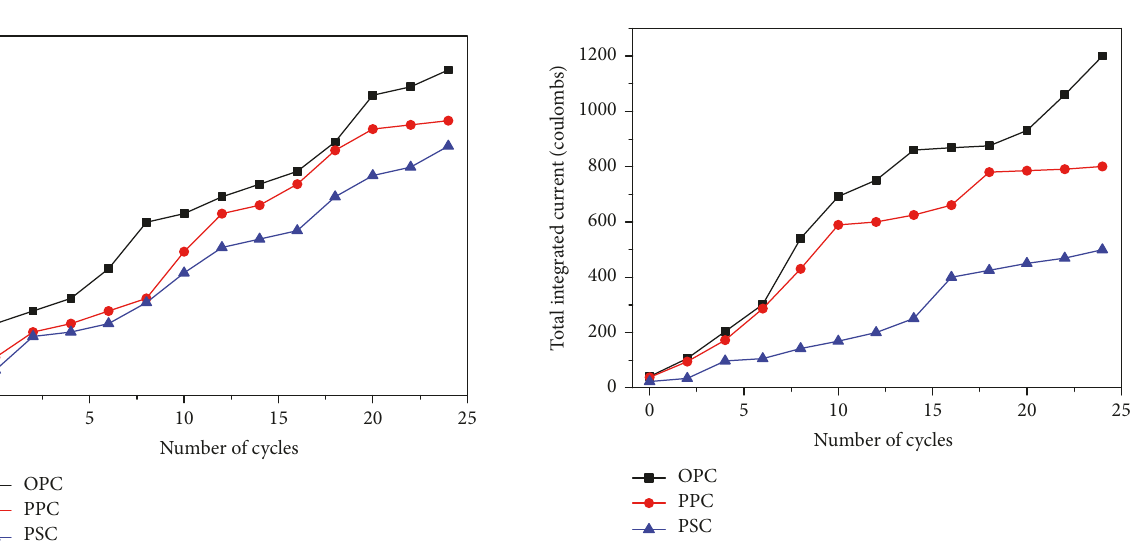
Figure 12: Macrocell current versus number of cycles of exposure for rebar in OPC, PPC, and PSC M30 grade concrete types (90-day cured specimens) under macrocell condition.